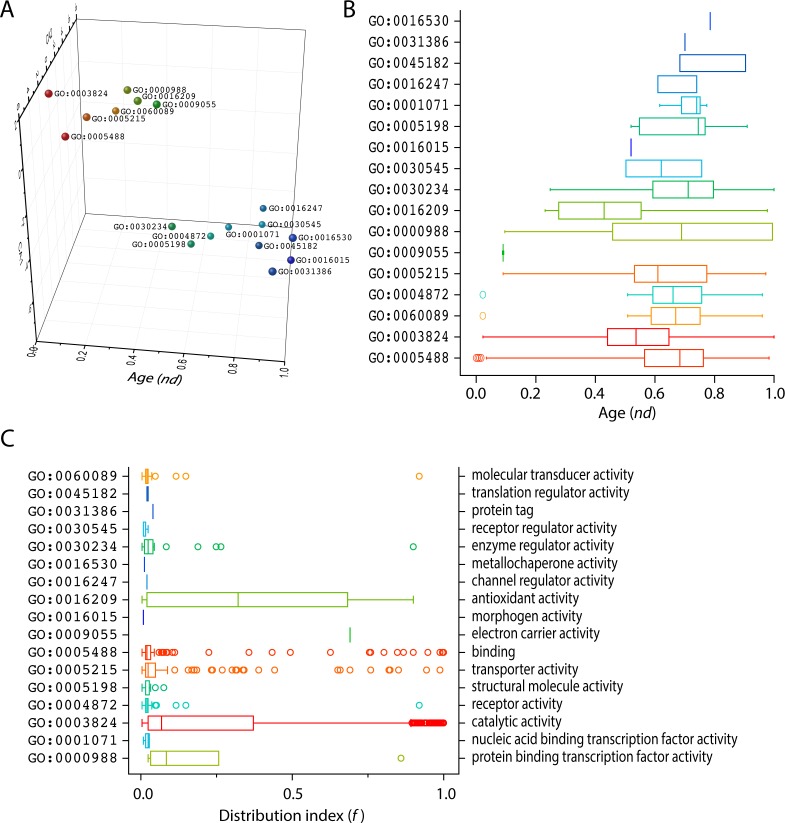
Evolution of level 1 molecular functions.(A) Correspondence Analysis (CA) of GOMF explains clusters of level 1 GO terms with respect to age (nd) and CA values. (B) Boxplot displaying the distribution of level 1 GO terms with respect to age (nd) in GOTMF terms of 249 organisms. (C) Boxplot displaying the distribution index of terminal terms categorized by level 1 GO terms.